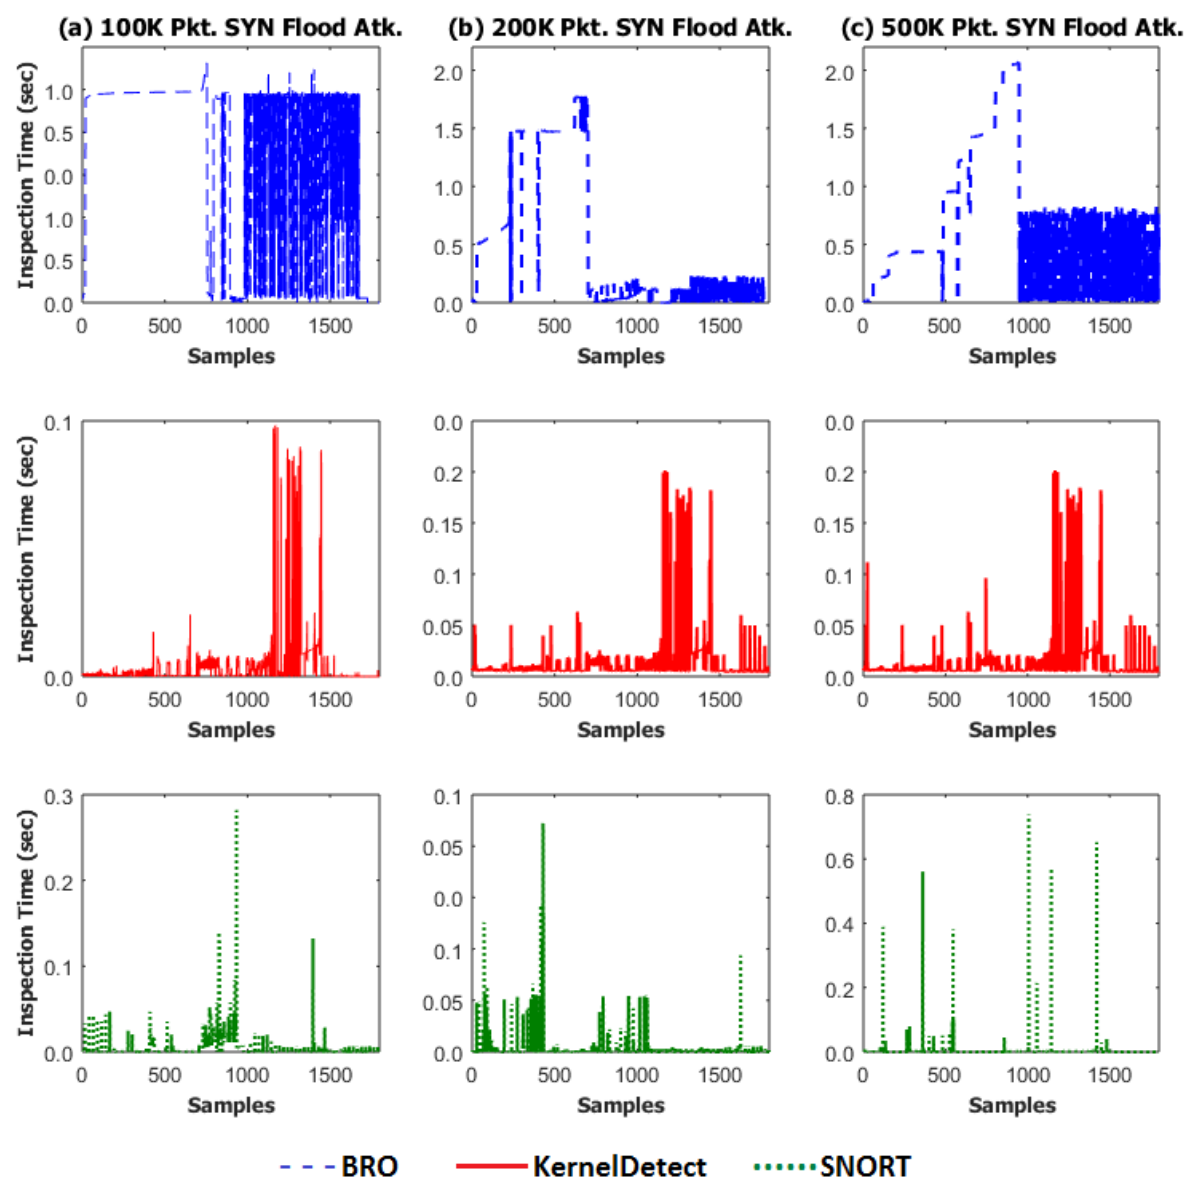
Figure 5. A comparative analysis of the inspection time for each IDS under 100K, 200K and 500K SYN flagged packet DoS attack using a 10 second threshold